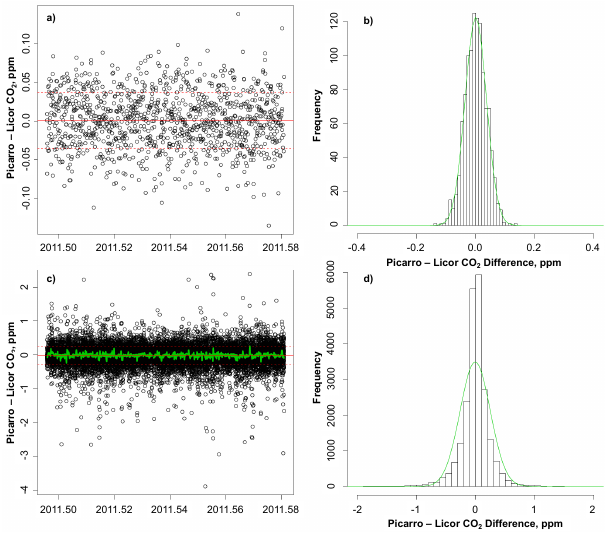
Fig. 11. Comparison of Li-cor and Picarro CO 2 analyzers at WGC. (a) Time series and (b) histogram of measurements of standard gases for the period 1–31 July 2011 with a mean difference of 0.00 ± 0.04ppm (1 σ) . (c) Time series and (d) histogram for ambi- ent air samples with 30s standard deviations < 0.3ppm. The mean difference is − 0.01 ± 0.26ppm (1 σ) .